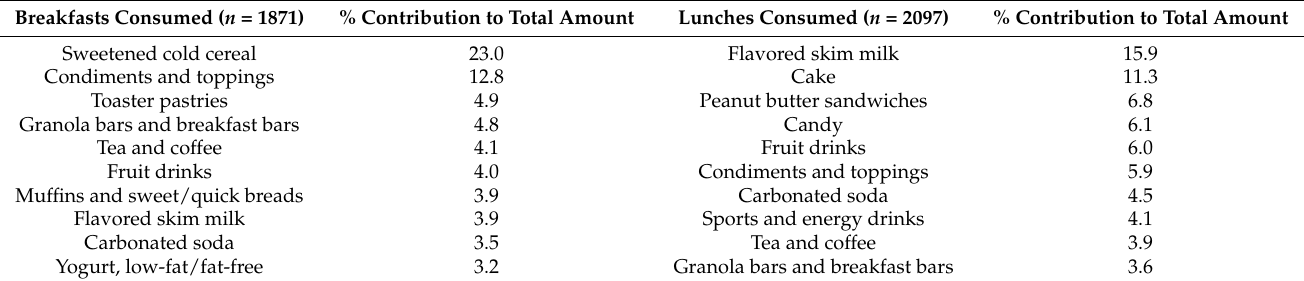
Table 4. Top ten sources of added sugars in breakfasts and lunches consumed by school-age children on school days. Breakfasts Consumed ( n =